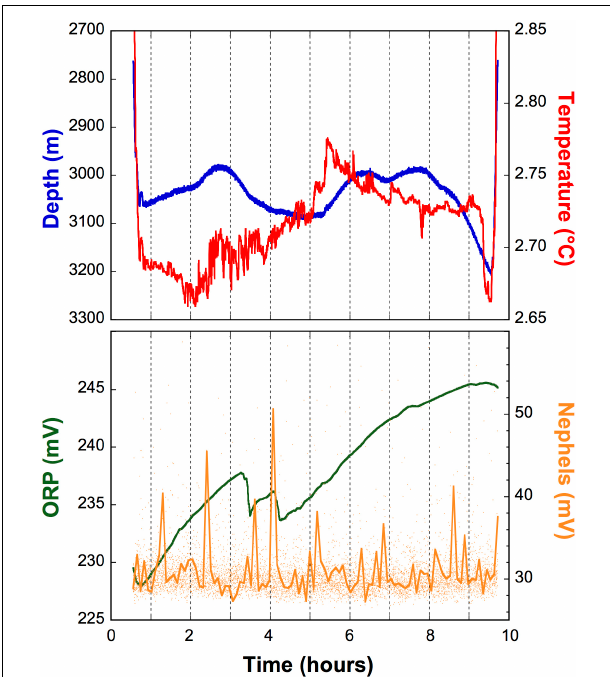
FIGURE 2 | Depth, temperature, oxidation-reduction potential (ORP), and backscatter (nephels) recorded during a TV-sled dive near the summit of Henry Seamount about 2 m above the seafloor. The two sharp ORP drops at ca. 03:20 and 04:10 h (cf. Figure 1C ) indicate the presence of reduced species in the bottom water as is typical of discharged vent fluids; these anomalies were confirmed by subsequent TV-sled dives. The gradual increase following each ORP drop is caused by drifting electrode potential in response to changes in ambient parameters (Baker et al., 2016). The nephels curve (cubic spline fit) shows a number of peaks due to sediment particles raised up by the sled, but no significant anomaly. The temperature variations are partly correlated with depth and reflect the thermal gradient in the ocean as well as oceanographic effects such as bottom currents. Temperature spikes caused by hydrothermal plumes are of much lower amplitude (Baker et al., 2016) and are not recognized